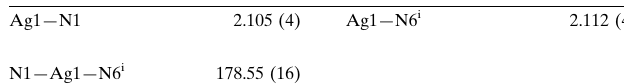
Selected geometric parameters (A˚ , (cid:1)